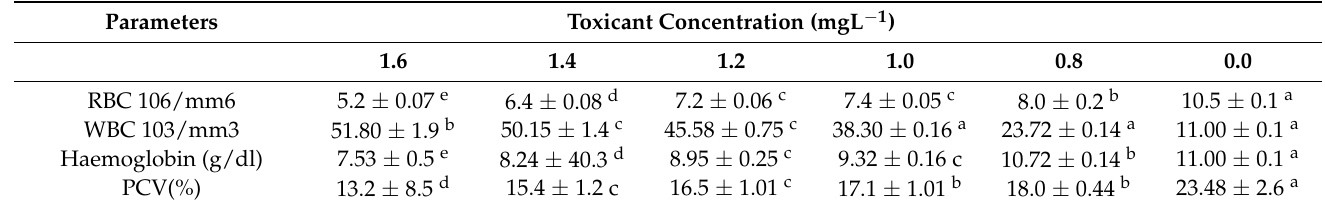
of Nittol for 96 h. Table 4. Mean Blood parameters ± SEM of Hetrobranchus bidorsalis exposed to acute concentra-